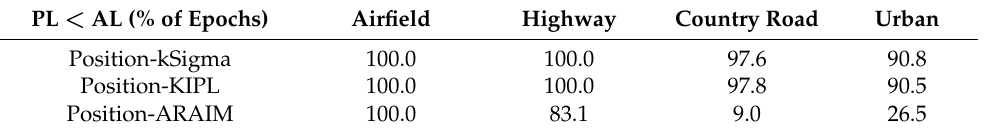
Table 8. Availability of the fusion filter with the implemented integrity algorithms. PL < AL (% of Epochs)